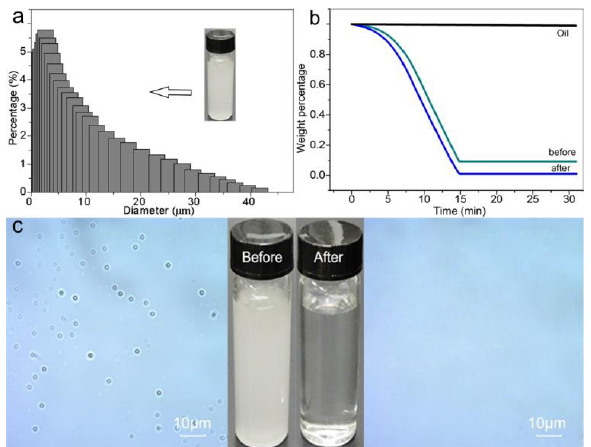
Figure 6. ( a ) the size distribution of oil droplets in mixture (olive oil); ( b ) the TGA curve of olive oil (as comparison), before and after separation; ( c ) the macroscope image of the solution before and after separation.